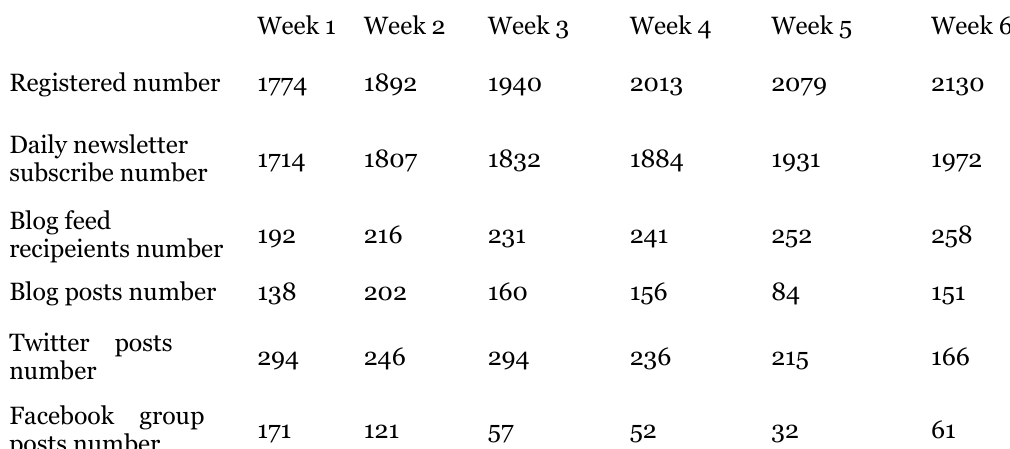
Number of Participants in Different Spaces Each